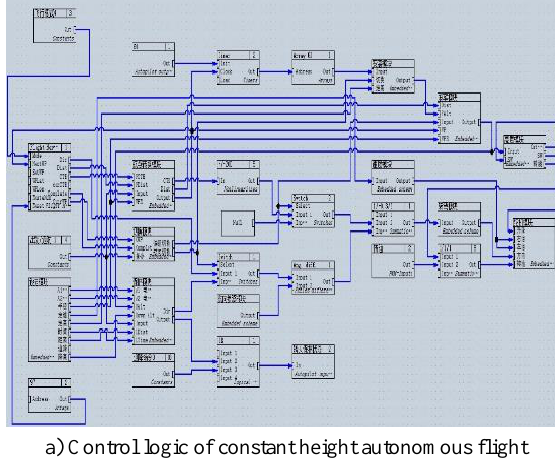
Figure 3. Comparison of match calibration of laser point clouds and digital images